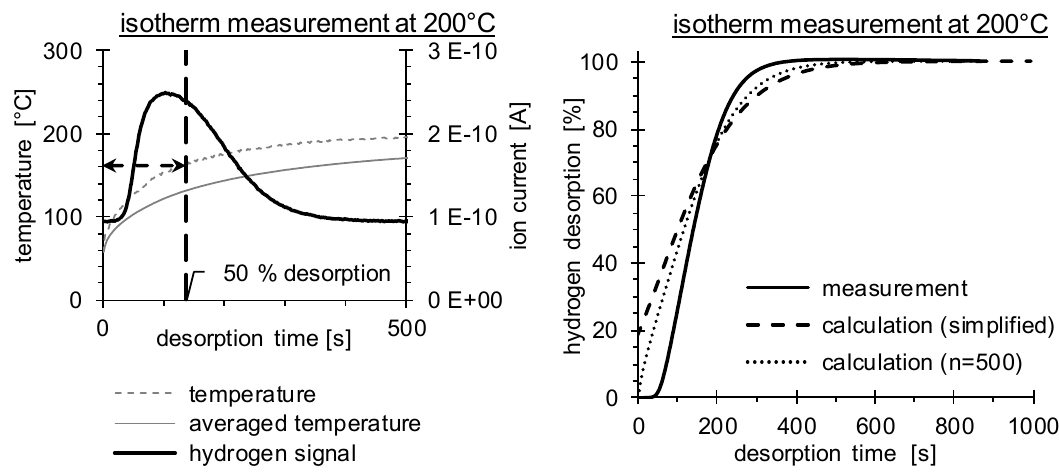
Figure 15. Hydrogen desorption of 22MnB5 during isothermal heating at 200 °C ( right ) and temperature curve ( left ).